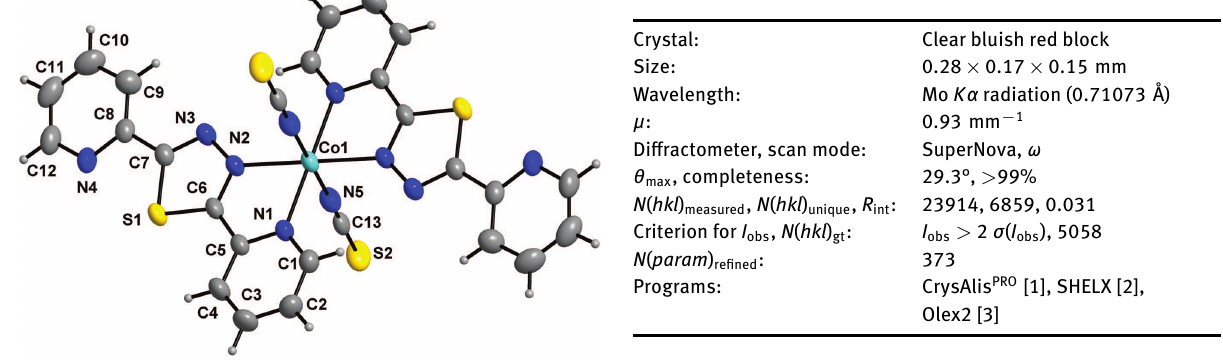
Table 1: Data collection and handling.